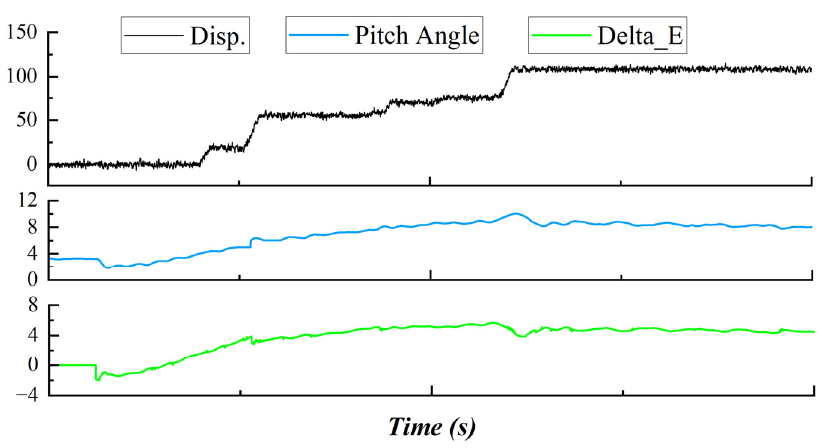
Figure 28. Height time history curves at different wind speeds: ( a ) 24 m/s and ( b ) 30 m/s.